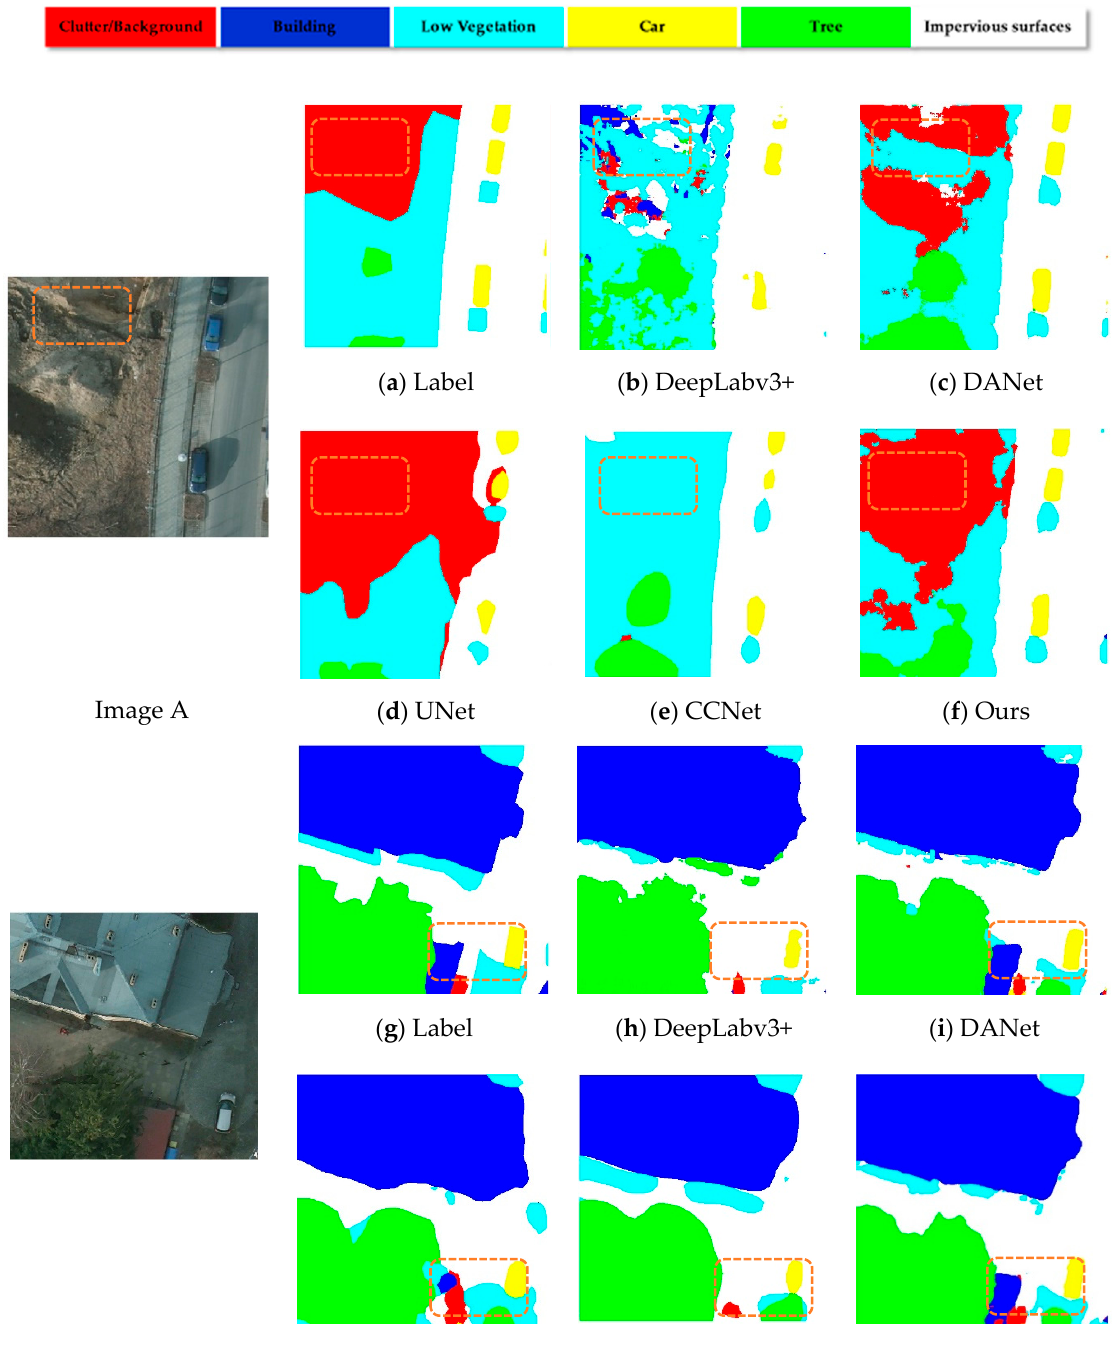
Figure 14. Qualitative comparisons between different methods applied to sample images.